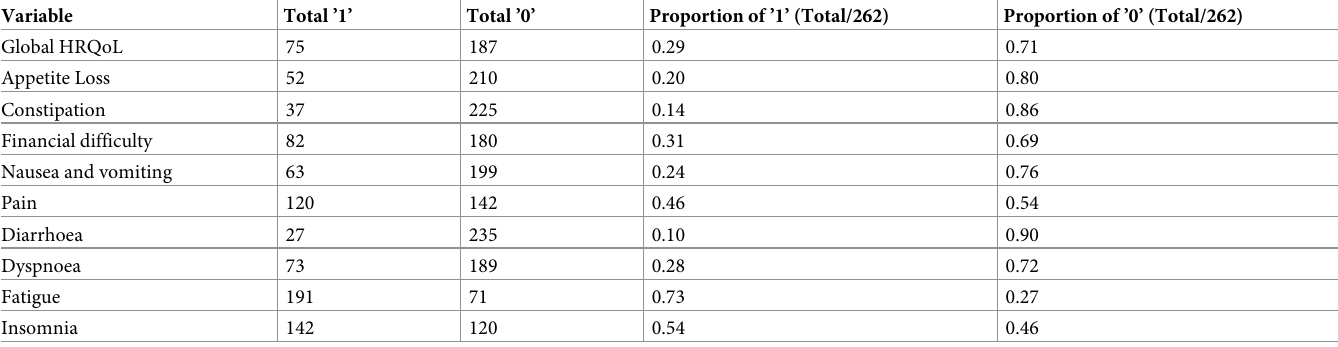
Table 2. Distribution of binarization for each of the 10 target outcomes in the